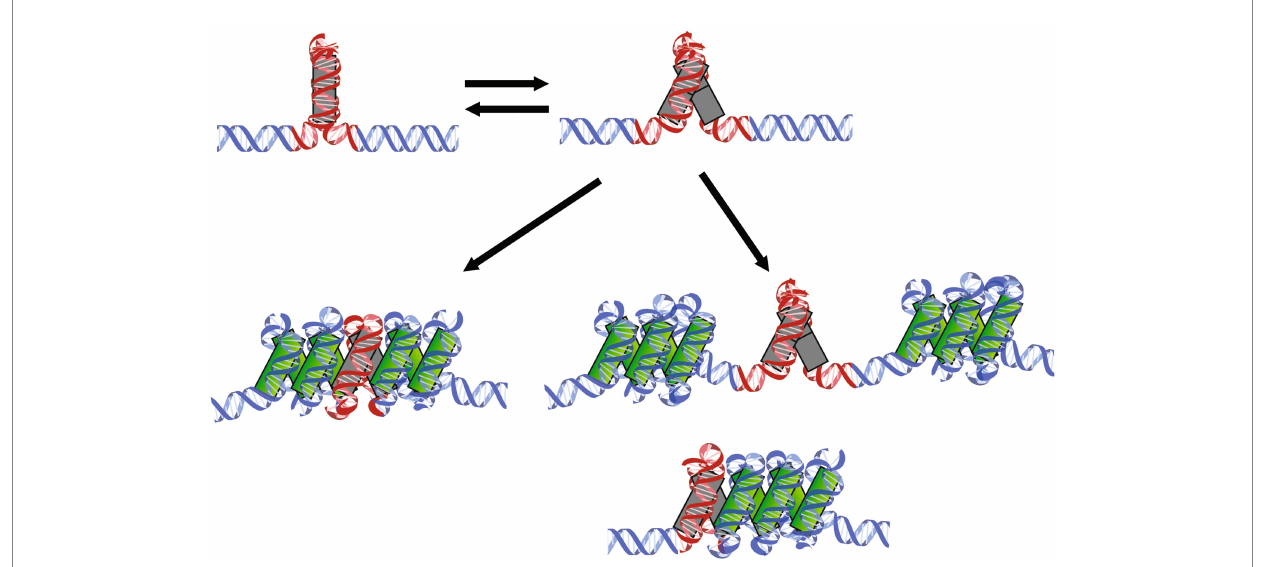
FIGURE 4 Mechanisms of HMf tetramers binding to specific DNA sequences followed by hypernucleosome formation. HMf tetramers bind to the Clone20 sequence and form a closed complex incompatible with further multimerization (top left). This structure can dynamically open and close (top right). The open structure can facilitate hypernucleosome formation (bottom left). If histone variants are bound that lack either stacking interactions or dimer-dimer interactions are bound, this tetramer could potentially act as a barrier of hypernucleosome progression or act as a ‘capstone’ (bottom right). Including different homo-and heterodimers into one structure could also result in limited extension of the